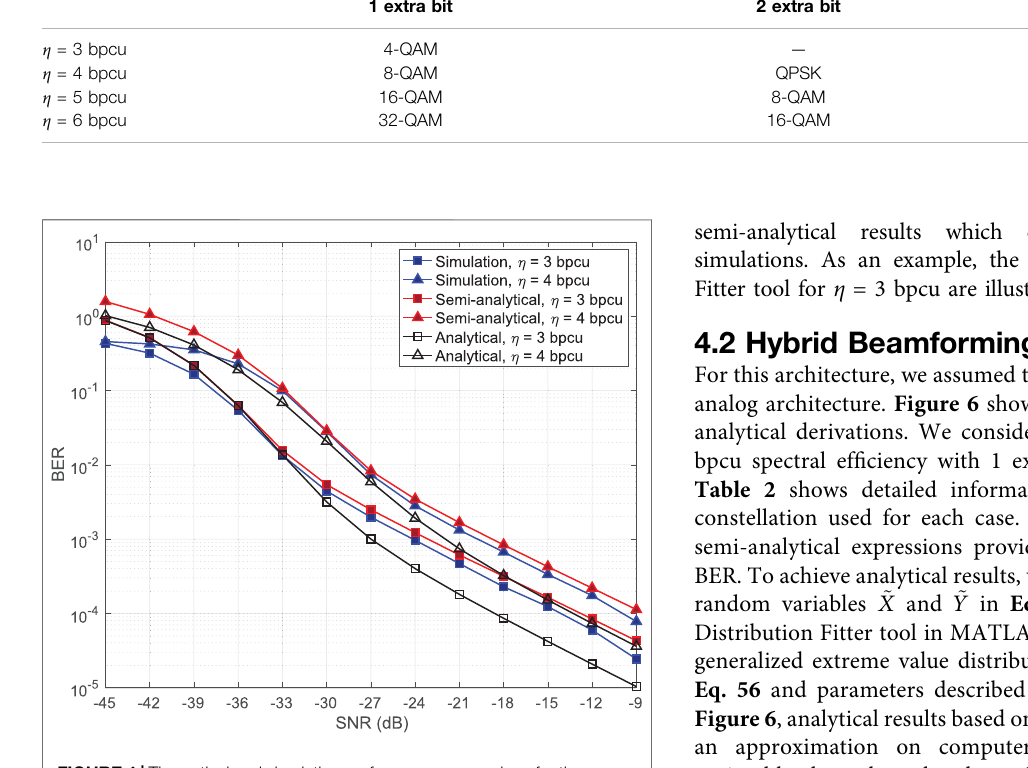
FIGURE 4 | Theoretical and simulation performance comparison for the analog architecture.